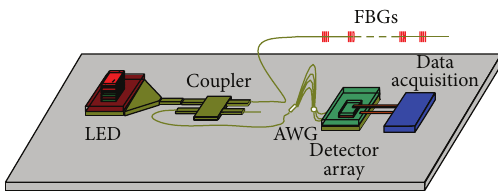
Figure 1: The proposed AWG demodulation integration microsystem.